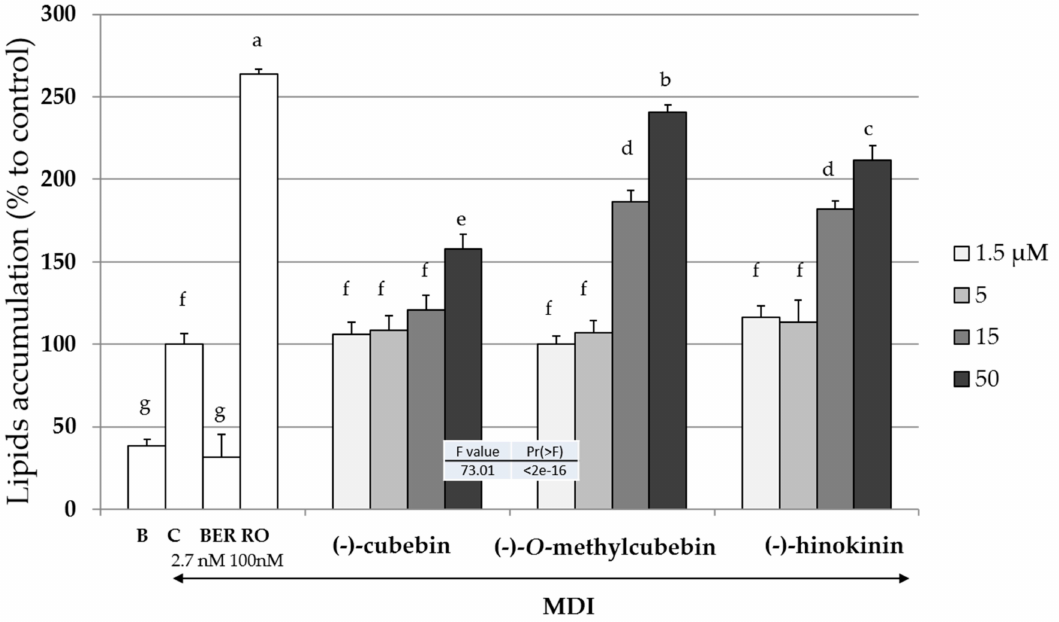
Figure 3. The e ff ects of the compounds isoloated from V. trifolia on the liped levels in 3T3-L1 cells. B (Black): Undi ff erentiated cells without the addition of the MDI mixture [a mixture of 0.5 mM 3-isobuty-1-methyl xanthine (M), 0.1 µ M dexamethasone (D) and 2 µ M insulin (I)], C (Control): cells with the addition of the MDI, BER: cells with MDI and berberine (2.7 nM), and RO: cells with MDI and rosiglitazone (100 nM). The arrow indicated the addition of the MDI mixture. Data are presented as the mean ± SD from three independent experiments. The same letters indicate that there are no di ff erences between those groups, and di ff erent letters indicate significant di ff erences ( P <